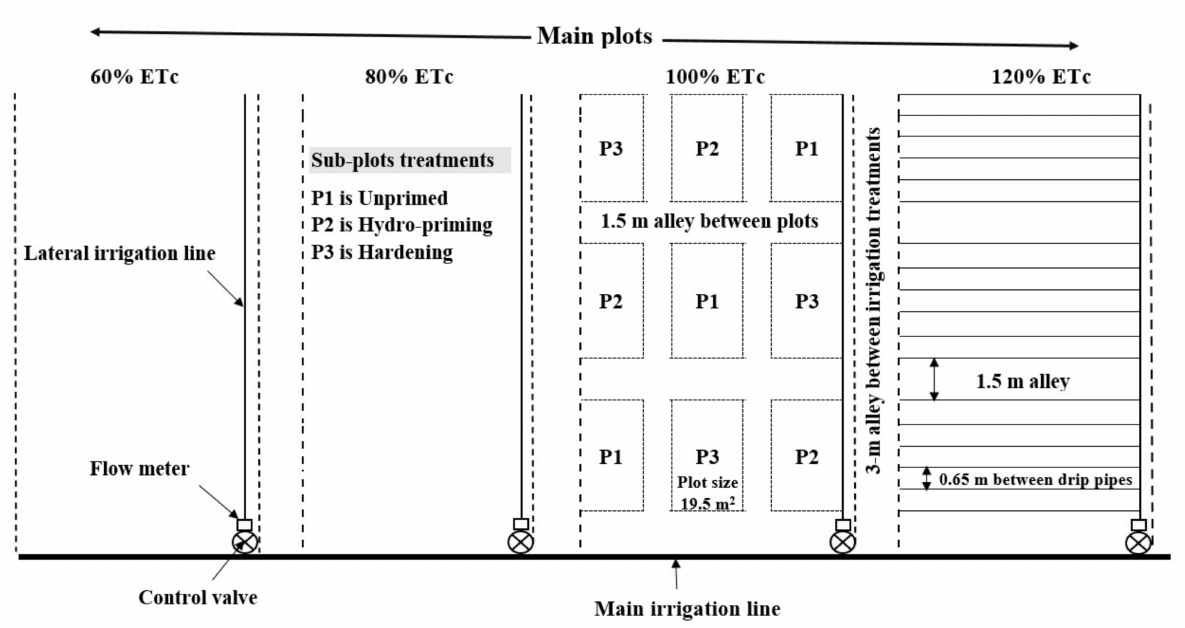
Figure 1. Layout of the experiment presenting four irrigation regimes in main plots and seed priming treatments in